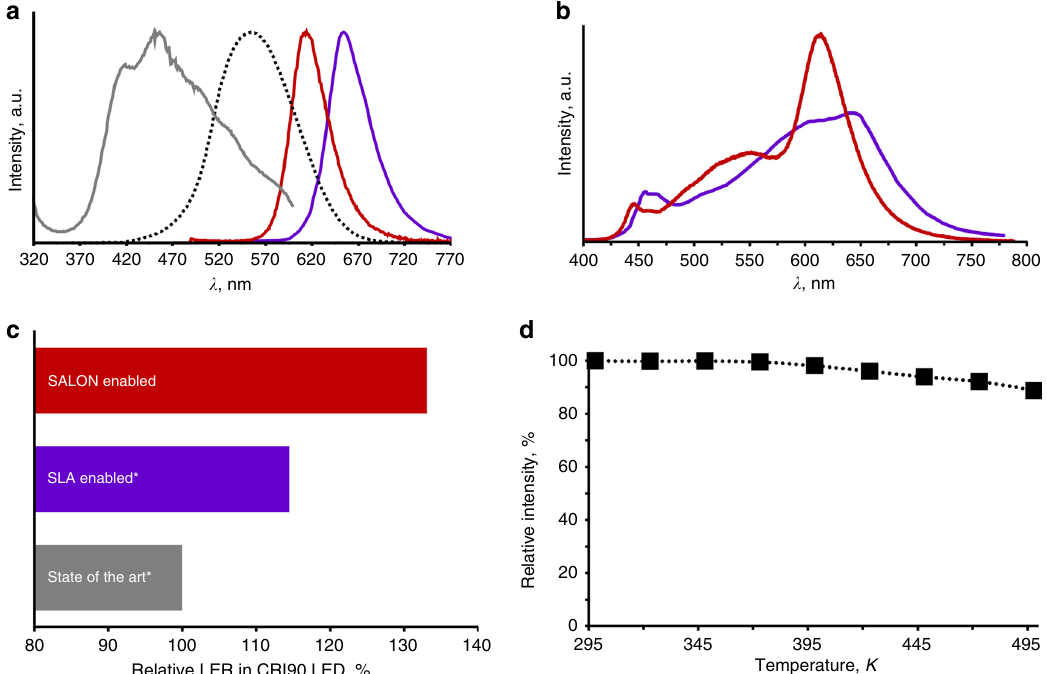
Fig. 4 Photoluminescence properties of SALON. a Normalized excitation (grey, for the emission at λ max equals 614 nm) and emission spectrum (red, excited with λ exc equals 460 nm) of SALON in comparison to Sr[LiAl 3 N 4 ]:Eu 2 + 22 , reference (purple, data taken from literature) and the human-eye sensitivity curve (black dotted). b Comparison of two warm-white pc-LEDs (CCT equals 2700 K, CIE coordinates (SALON based LED): x/y equals 0.463/ 0.415; CIE coordinates (SLA based LED): x/y approximately equal 0.455/0.405, spectra normalized to integral intensity) with high colour rendering index (CRI greater than 90, R9 greater than 40). Purple curve taken from literature (Sr[LiAl 3 N 4 ]:Eu 2 + as red phosphor), the red curve represents a mid-power pc-LED using the SALON phosphor as red component. c Relative luminous ef fi cacy of radiation (LER) values for different warm-white pc-LED solutions (data normalized to the state of the art). Solutions marked with an asterisk are taken from the literature 22 . The solid red bar represents the relative LER value for the SALON containing phosphor solution with R9 greater than 40. d Relative photoluminescence intensity of SALON measured from 298 K